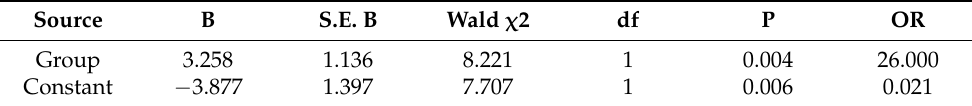
Table 2. Relationship of milk lactose with